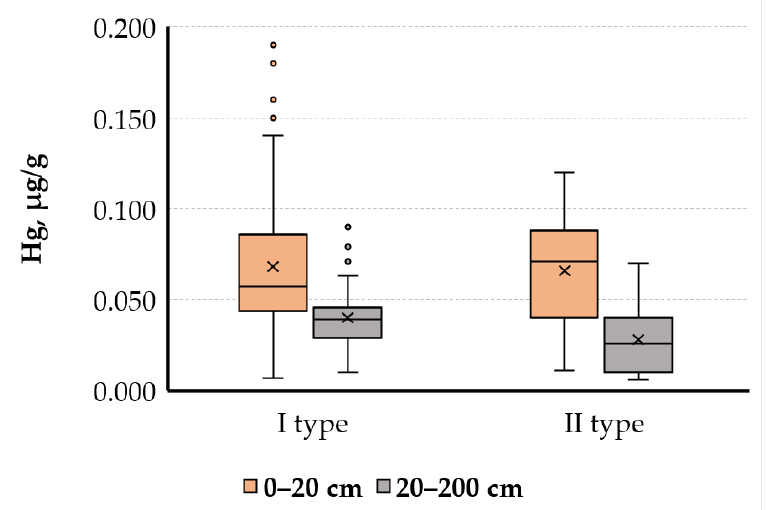
Figure 5. Mercury content in the first (I) and second (II) type of bottom